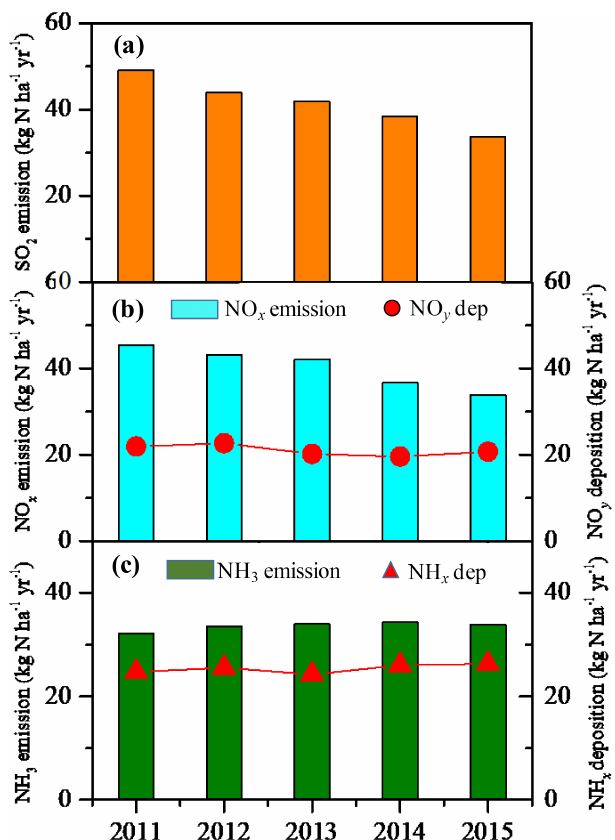
Figure 12. Emissions of SO 2 (a) , NO x (b) , and NH 3 (c) obtained as average data from the areas belonging to eastern China, compared with deposition (dep) values in the same periods (mean values from the 16 sites showing in Fig. S6 and Table S1 in the Supplement, 5-year